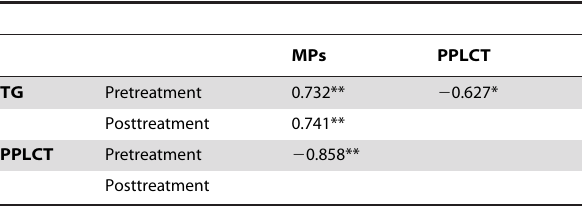
Table 2. Spearman’s bivariate correlation between MP and coagulation markers.